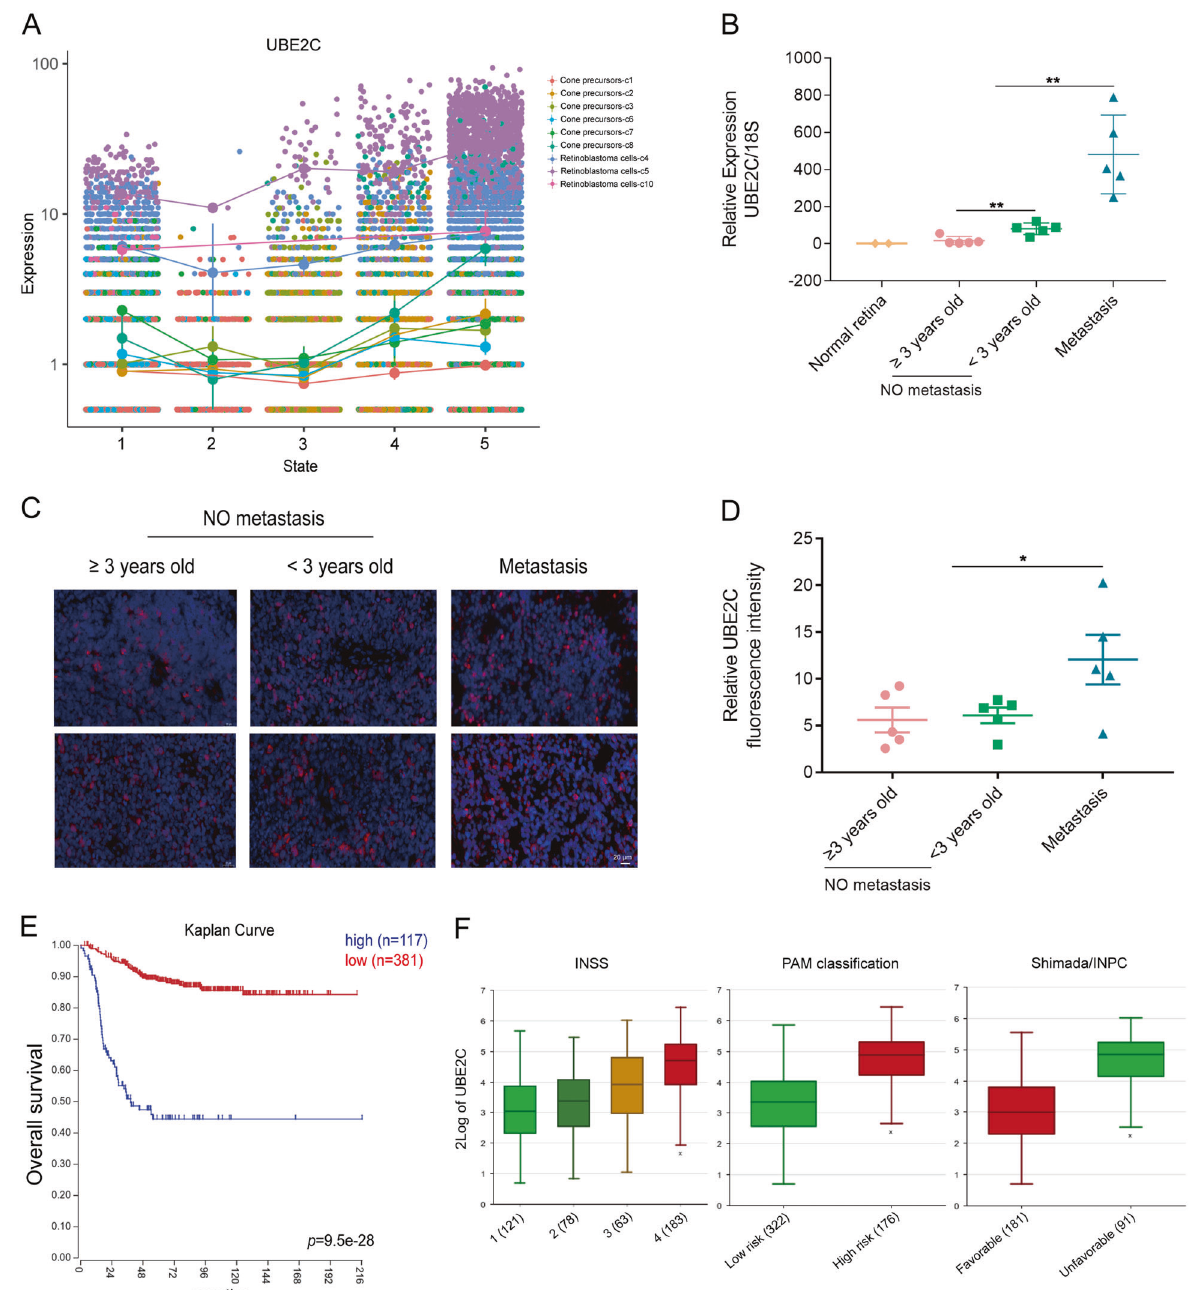
Fig. 6 UBE2C is an independent prognostic factor in retinoblastoma. A Jitter plots showing the expression level of the UBE2C changing with pseudotime, colour-coded according to cell clusters (c1, c2, c3, c4, c5, c6, c7, c8, c10). B Real-time PCR showed UBE2C expression in retinoblastoma and normal tissues. ** P < 0.01. C IF staining of UBE2C in different age stages and metastasis/nonmetastatic retinoblastoma. Bars: 20 μ m. D The results of IF analysis of UBE2C expression are presented of the mean number of the UBE2C -positive rate. * P < 0.05. E Correlation between UBE2C mRNA expression and neuroblastoma patient survival in the TCGA dataset. Overall patient survival in groups with high and low UBE2C expression was analysed using a Kaplan – Meier survival curve. F High-level UBE2C mRNA expression in neuroblastoma correlates with unfavourable clinical features, including high INSS stage, high risk of PAM classi fi cation and unfavourable Shimada/INPC in a cohort of 476